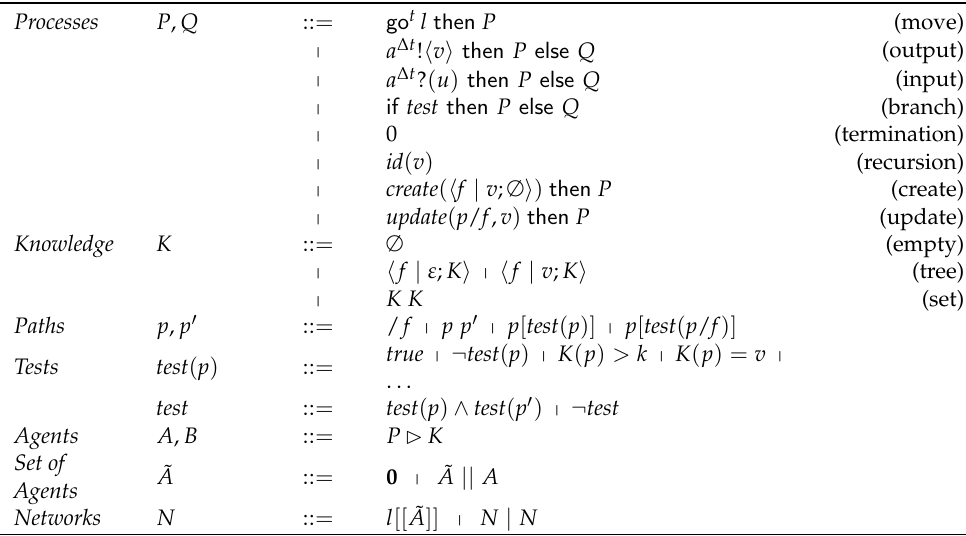
Table 1. Syntax of our Multi-Agent